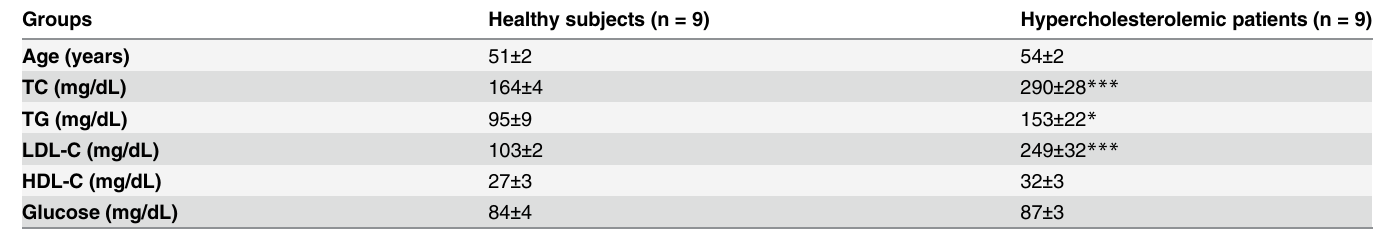
Table 1. Information of healthy subjects and hypercholesterolemic